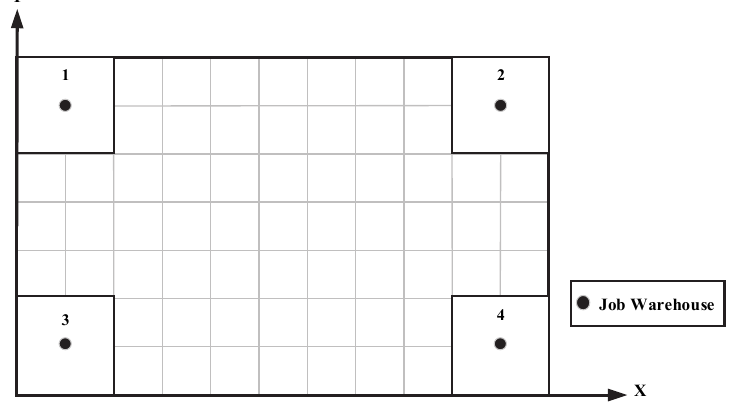
Fig. 2. Continuos parallel machine ScheLoc